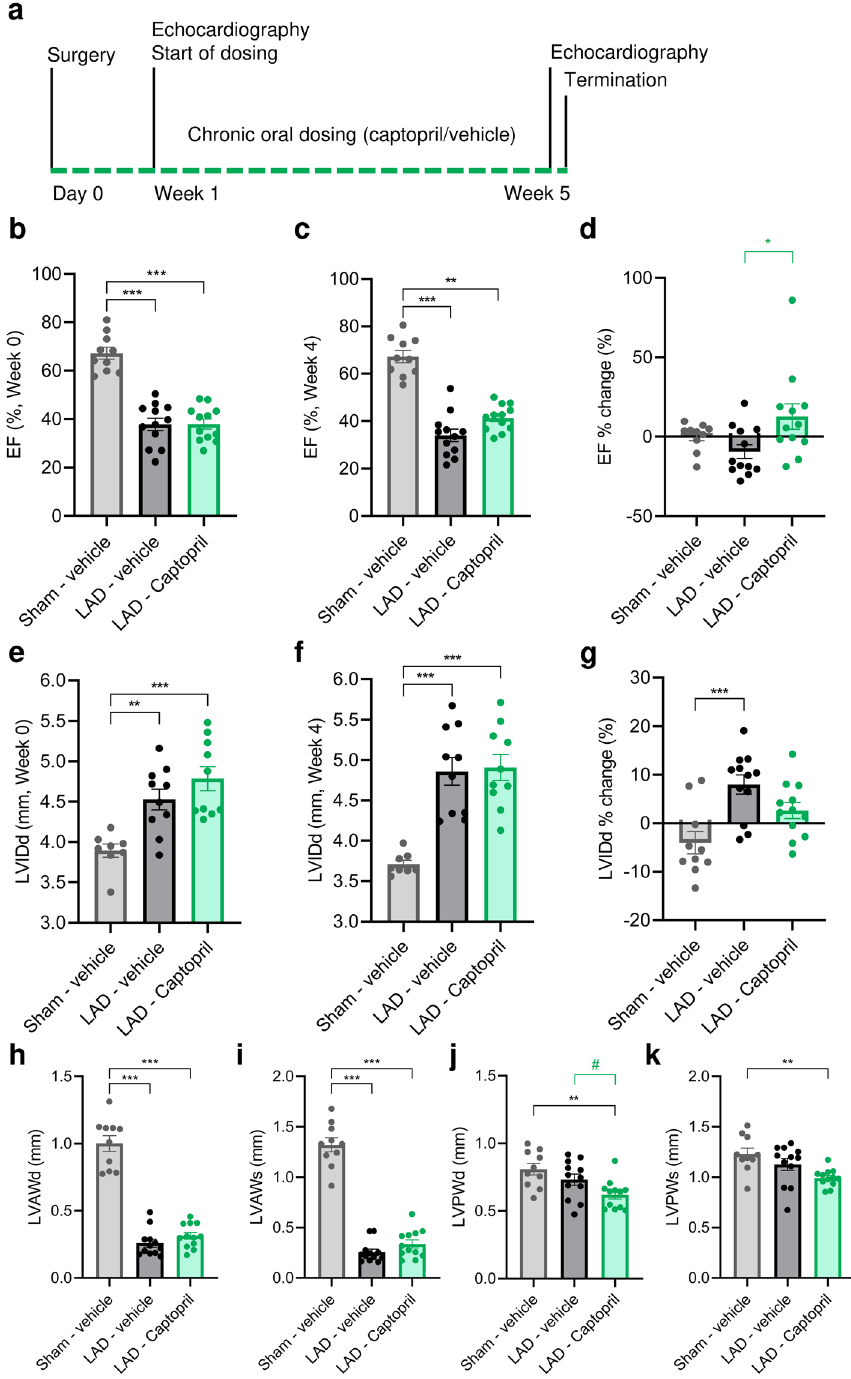
Figure 1. Echocardiographic evaluation of cardiac function and remodelling in a mouse model of myocardial infarction. ( a ) Schematic study outline. ( b ) Ejection fraction (EF) at the time of inclusion in week 0. ( c ) EF after 4 weeks of dosing with either vehicle or captopril. ( d ) EF change over study period (week 4-week 0)/week 4*100%. ( e ) Left ventricle internal diameter in diastole (LVIDd) at the time of inclusion in week 0. ( f ) LVIDd at week 4. ( g ) LVIDd change over study period. ( h ) Left ventricle anterior wall dimension/thickness (LVAW) in diastole and ( i ) systole. ( j ) Left ventricle posterior wall dimension/thickness (LVPW) in diastole and ( k ) systole. Data is presented as mean ± s.e.m. n = 10–12. One-way ANOVA with Tukey’s post hoc test. Significance: *p < 0.05, **p < 0.01, ***p < 0.001. #: Significant (p < 0.05) after removal of single non-responder in LAD— Captopril. LAD: left anterior descending artery